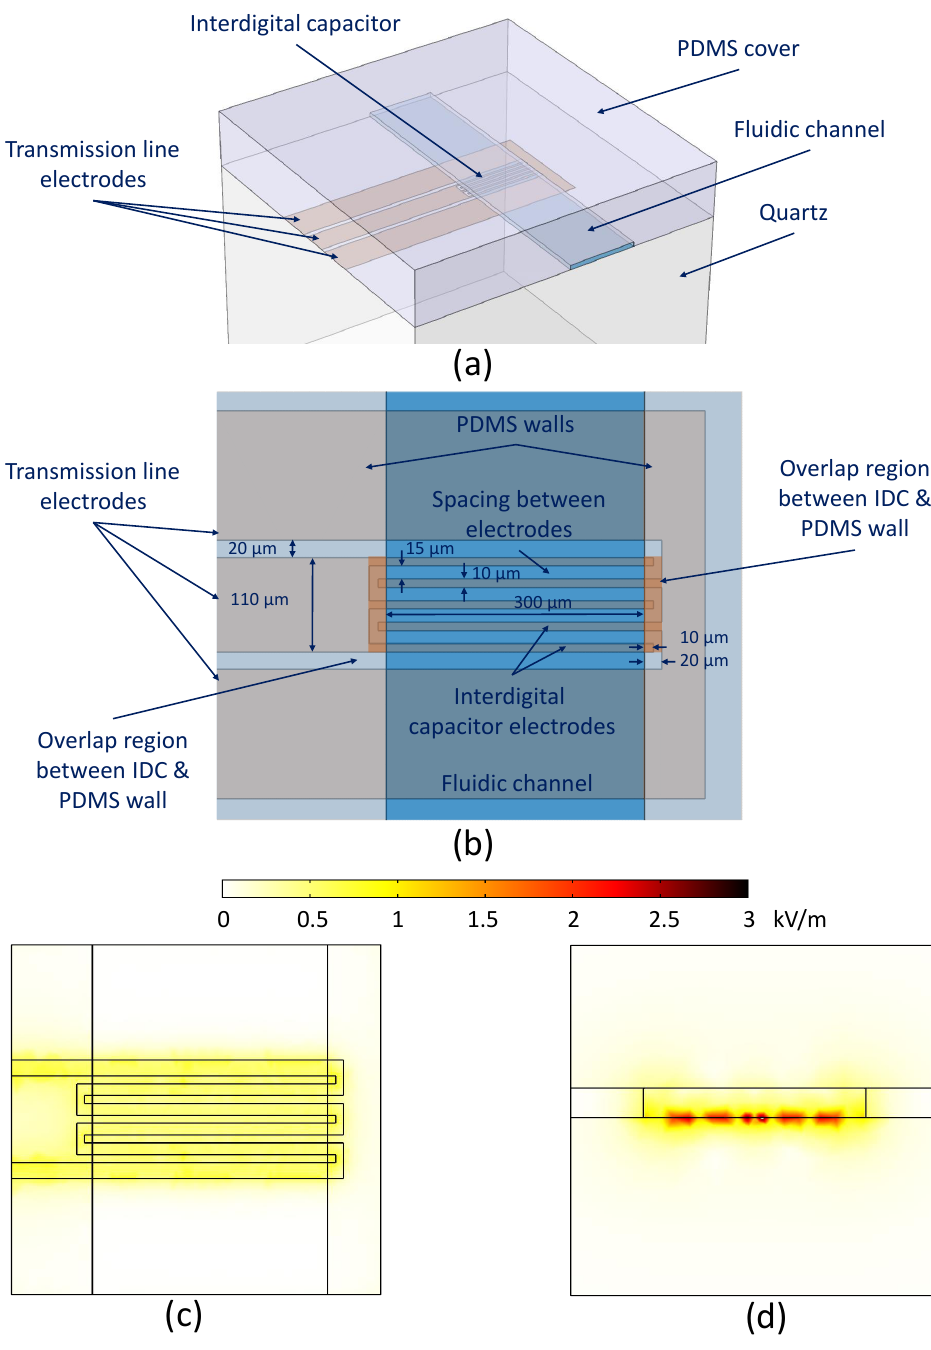
Figure 2. ( a )A 3D model of the proposed IDC sensor. ( b ) Top view of the proposed IDC sensor with designed diameters. ( c ) Top view of the electrical field distribution at 1 GHz 10 µ m above the surface of quartz. ( d ) Side view of the electrical field distribution at 1 GHz across the IDC fingers in the middle of the liquid